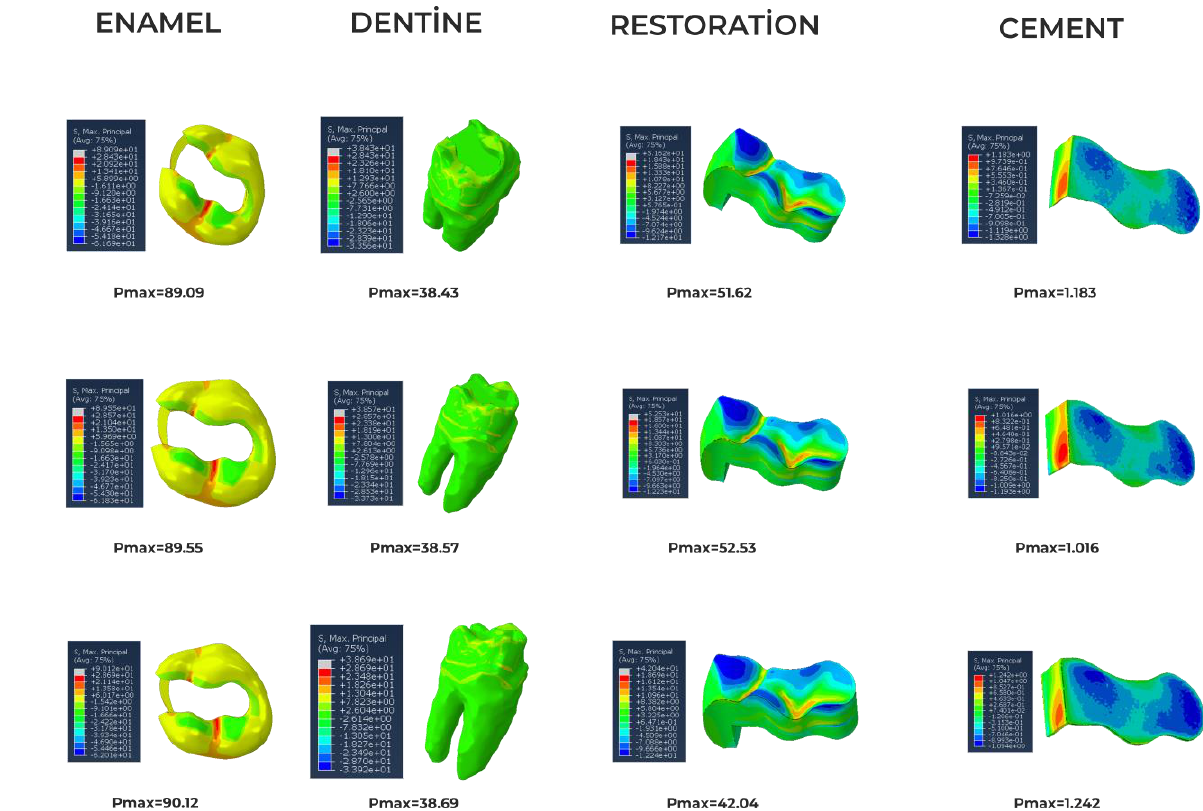
Figure 7. Maximum principal stress (MPa) distribution within the enamel, dentin, restoration, and different thicknesses of resin cement under 600 N of total force applied to the occlusal surface (V2; Poisson’s ratio: 0.24 ) with the amalgam.